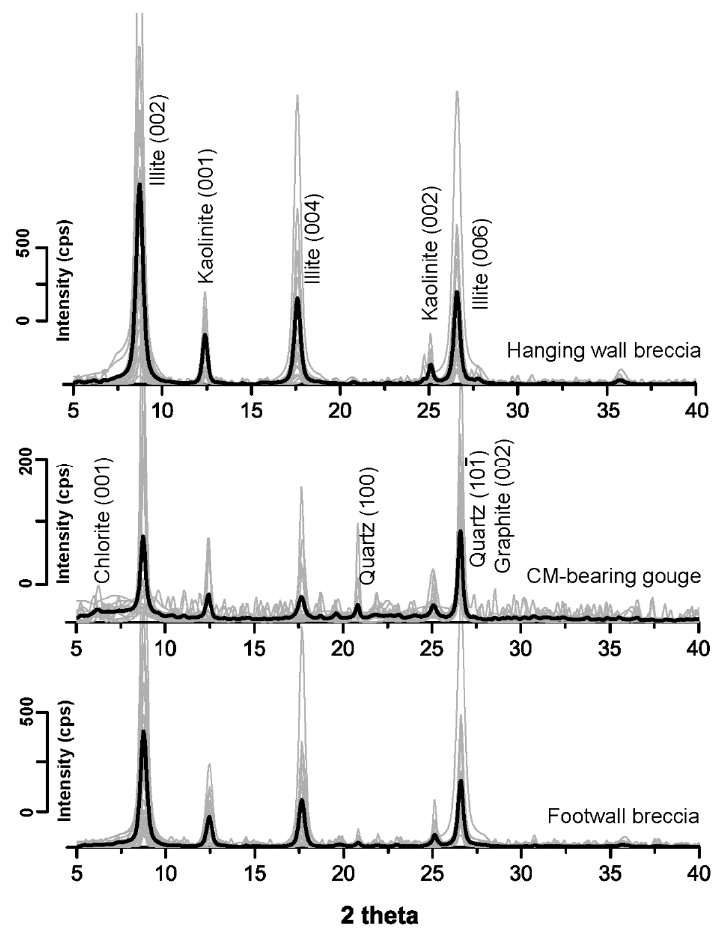
Figure 2. Characterization of mineral phases of FZ760 samples. The mineral phases of breccia are very similar to that of the gouge zone. Comparing the intensity (002) (004) (006) of illite, the XRD data of CM-bearing gouge demonstrated the presence of quartz and graphite. cps, counts per second.